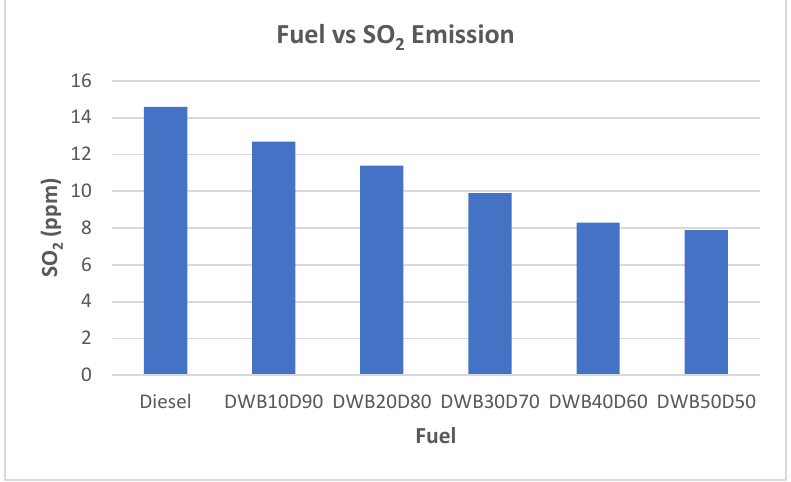
Figure 12. SO 2 emission from engine using diesel and diesel blended with distilled WCO biodiesel. The results show that CO 2 emissions were higher for blended fuel than mineral